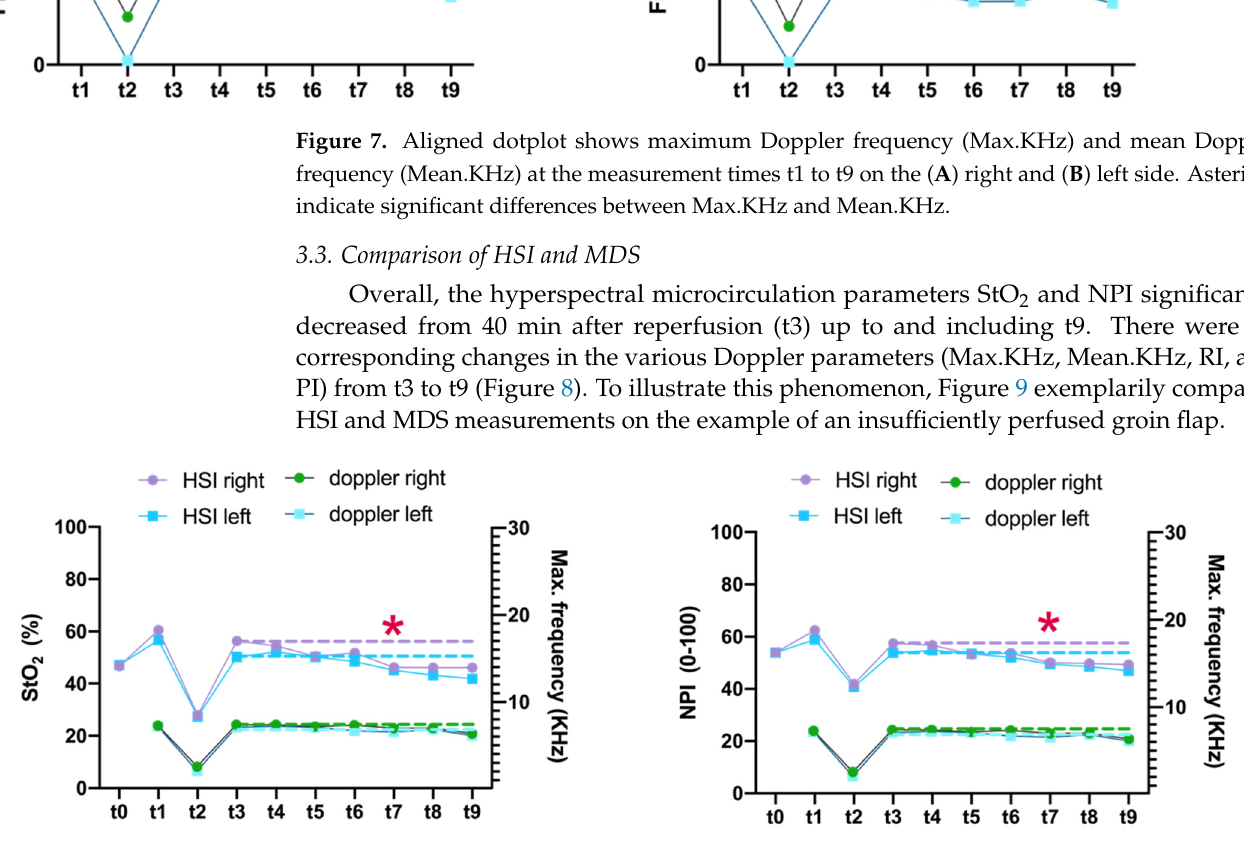
Figure 8. Aligned dotplots illustrate the lack of change compared to the hyperspectral parameters StO 2 and NPI on the example of the maximum Doppler frequency (Max.frequency KHz). The red asterisk indicates onset of significant decreases in StO 2 and NPI at t7. The dashed lines indicate the parameter value level at